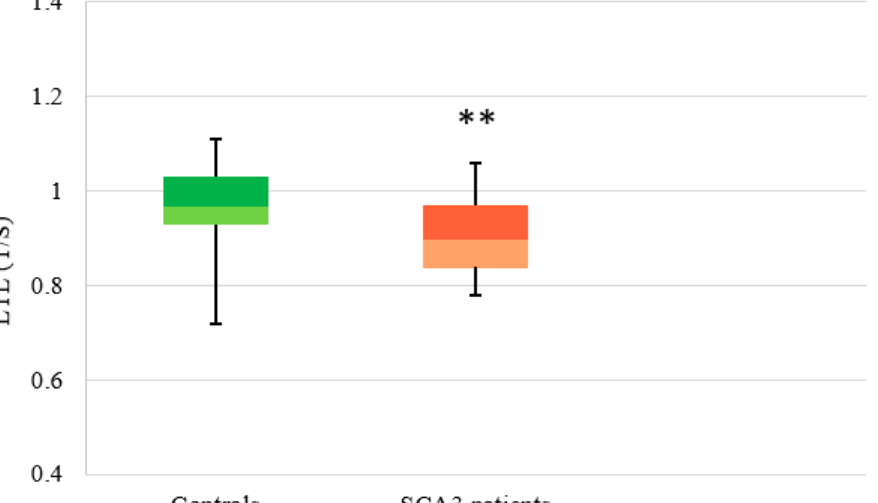
Figure 5. Distribution of LTL in controls and SCA3 patients. Box plot showing the distribution of LTL (T/S ratio) (the number of copies of telomeric repeats T compared to a single copy gene S) used as a quantitative measure in controls (n = 50) (median: 0.97, Q1: 0.93, Q3: 1.03) and SCA3 patients (n = 29) (median: 0.90, Q1: 0.84, Q3: 0.98) (** p < 0.01).